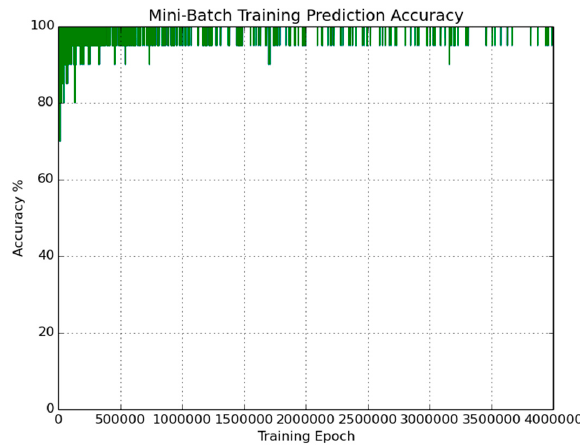
Figure A2. Mini-batch training accuracy curve.